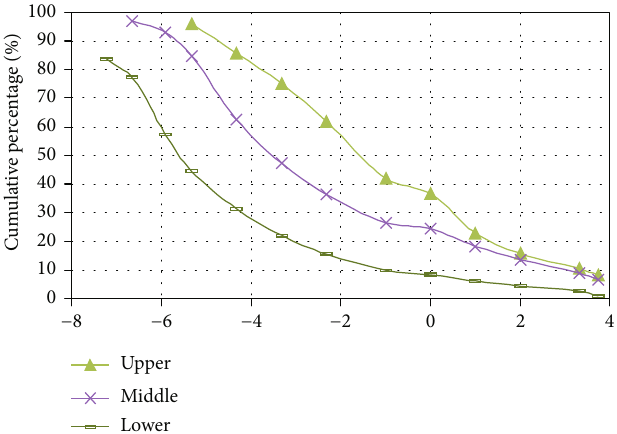
Figure 7: Sediment particle analysis in the distal area of